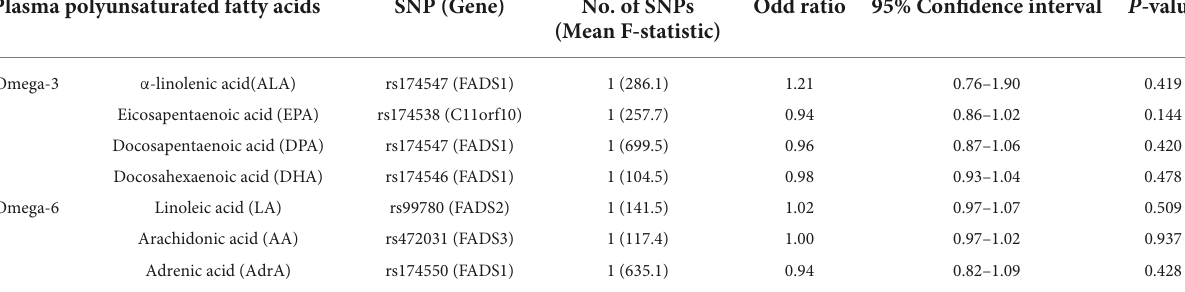
TABLE 3 Mendelian randomization (MR) estimates of causality between plasma polyunsaturated fatty acids and sleep apnea (FADS, C11orf10, and ELOVL gene loci). Plasma polyunsaturated fatty